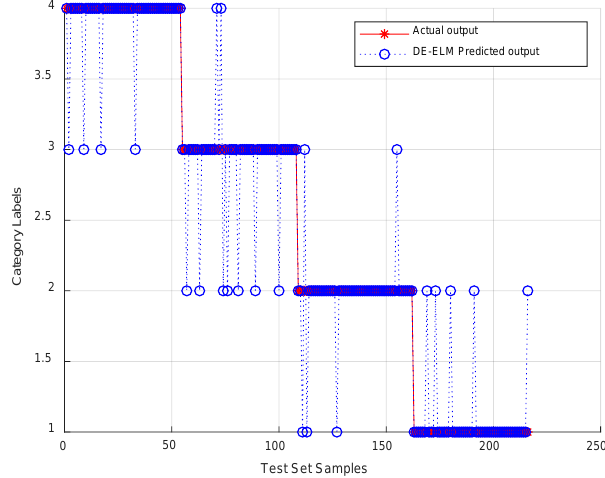
Figure 9. DE-ELM (100 nodes)-based fatigue state detection results.